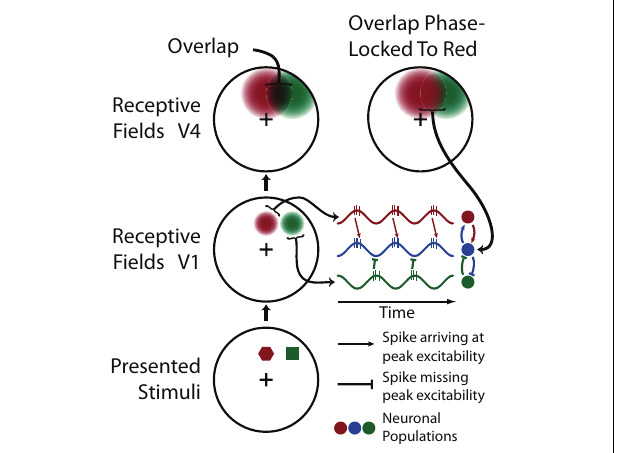
FIGURE 4 |A schematic representation of the CTC hypothesis and its implications. This illustration shows three neuronal populations (red, green, and blue).There are two populations (red and green) that each connect to the third (blue), but only one (red) is synchronized to it via neuronal oscillations (middle right), while the other (green) is out-of-phase. Spikes from the synchronized population (red) arrive at their target population (blue) within the peak of excitability, while signals from the out-of-phase population (green) have no effect. Such phase-locking process could explain why higher cortical areas show larger attention effects.When two stimuli are simultaneously presented, the corresponding retinotopic regions in lower level visual cortex (e.g.,V1) will overlap less than in higher level visual cortex (e.g.,V4). Neurons in subsequent cortical areas that can in principle respond to either stimulus can only be phase-locked to input from one of the stimuli, leading to competitive interactions in the region of